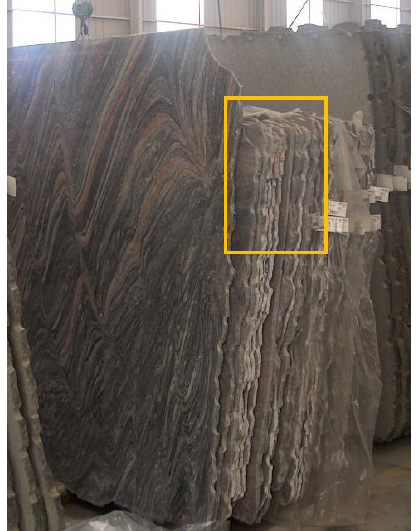
Figure 4. Granite slabs with manually applied colour codes (boxed area) used to identify